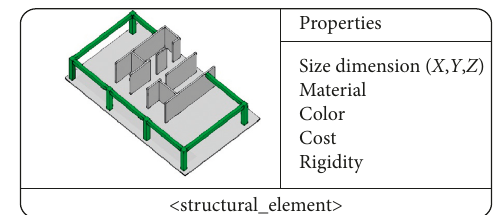
Figure 11: A structural element with a new ontology.